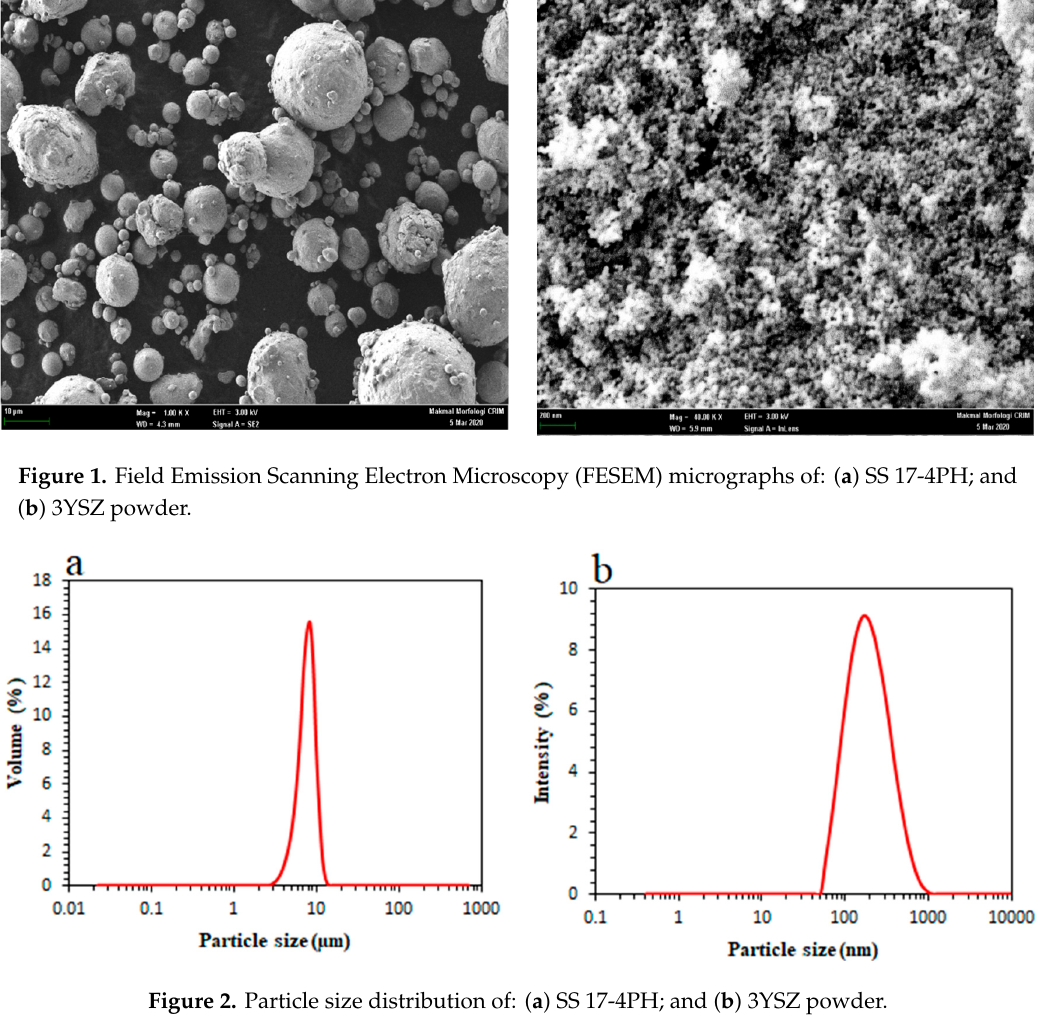
Figure 2. Particle size distribution of: ( a ) SS 17-4PH; and ( b ) 3YSZ powder. Table 1. Characteristics of the PS and LDPE binders.